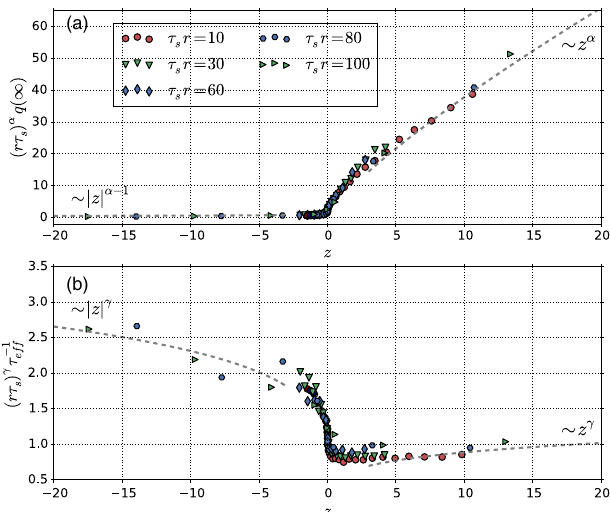
FIG. 12. Scaling behavior near criticality. (a) Rescaled α q ð ∞ Þ and (b) inverse form for the normalized variance, ð r τ s Þ γ τ − 1 , using the scaling variable effective relaxation time ð r τ s Þ eff z ¼ τ r j ϵ j β sign ð ϵ Þ . The data reveal the underlying scaling func- s tions f ð z Þ and F ð z Þ , respectively, consistent with Eqs. (77) and (80). Dashed lines show the predicted asymptotic behavior (see text). Simulations are performed on a Gaussian network of various sizes ( N ¼ 2000 , 3500, and 6000, h 0 ¼ 1 ) and with various synaptic time scales (see legend). Effective relaxation was calculated from simulations by taking τ R eff ¼ R τδ Δ ð τ Þ d τ = δ Δ ð τ Þ d τ for τ ≥ 0